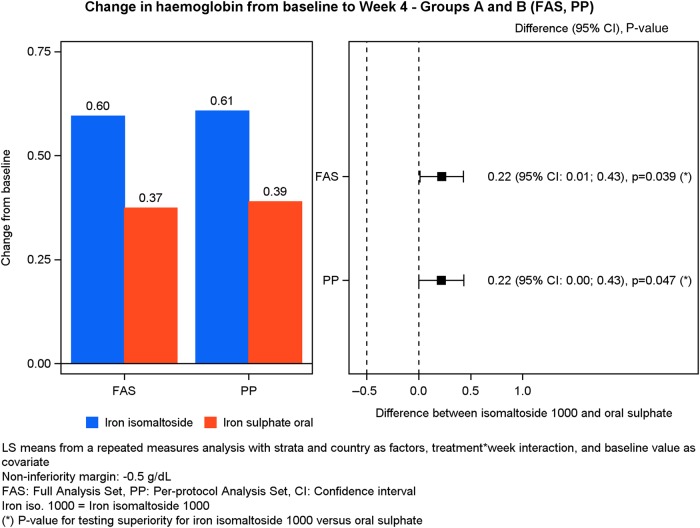
Change in Hb from baseline to Week 4.